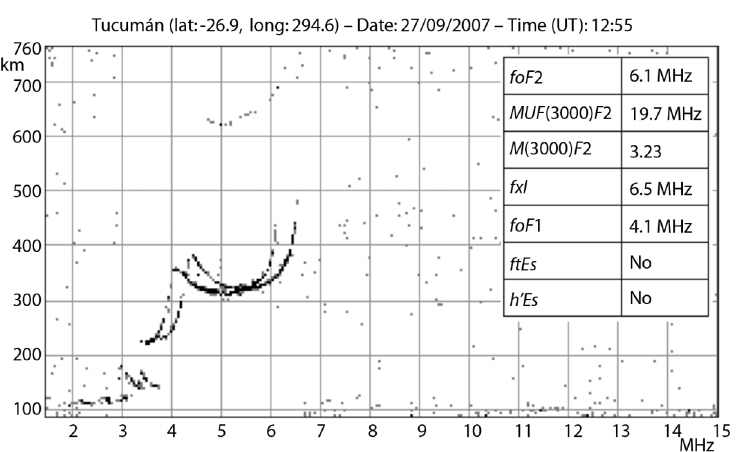
Fig. 4. An example of a daytime ionogram recorded on 27 September 2007 at 12:55 UT by the AIS-INGV ionosonde installed at Tucumán, and autoscaled by